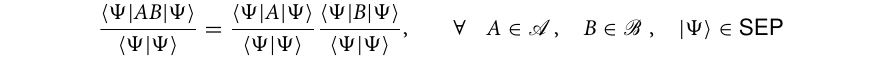
L R 0 (effectively distinguishable � | � = L R 1 � | � ≈